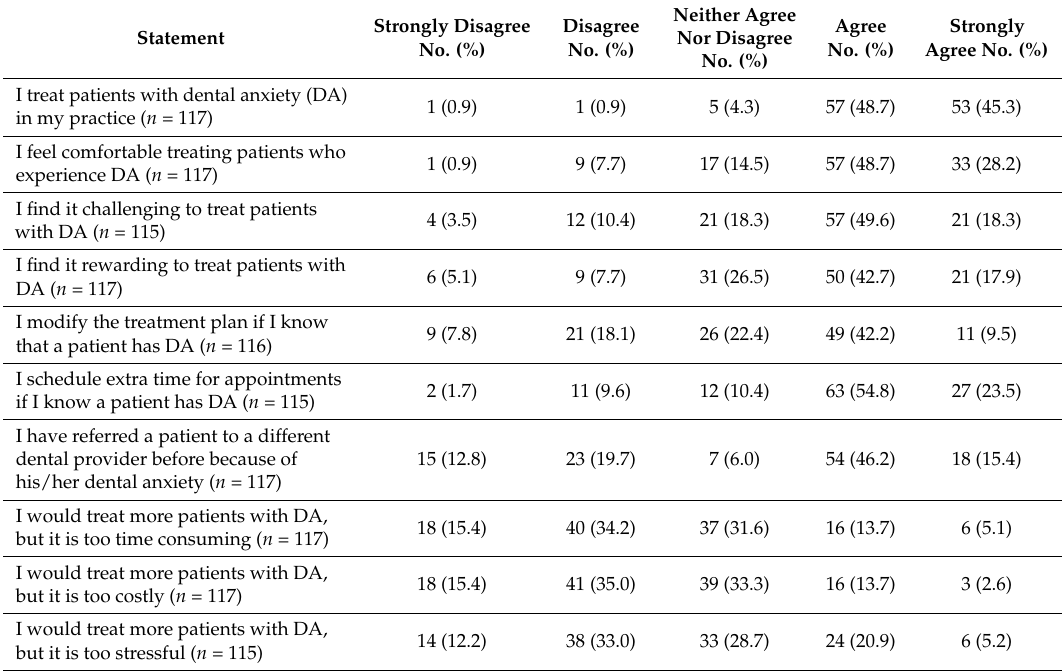
Table 2. Ohio dentists’ practice patterns and attitudes about patients with dental